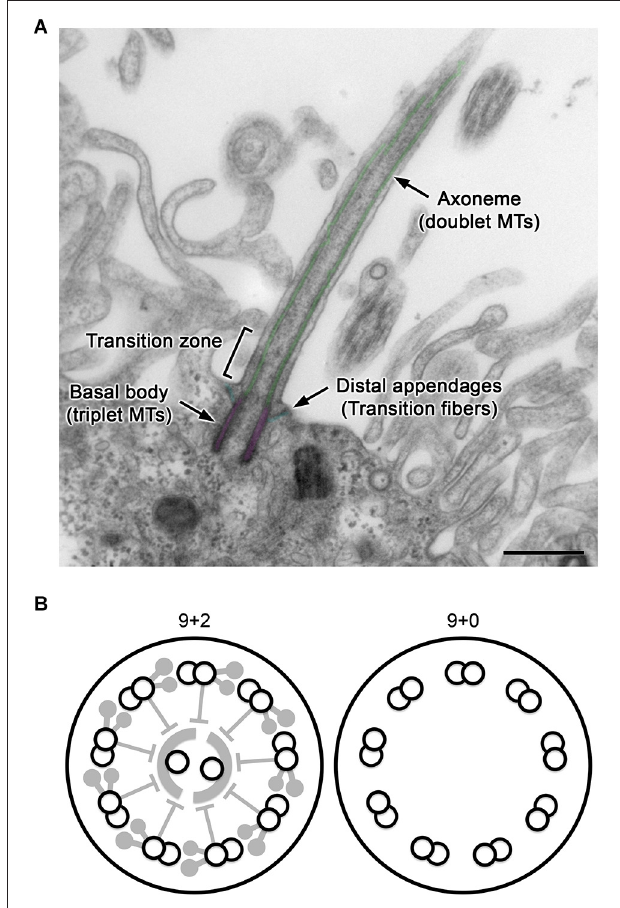
FIGURE 1 | General structure of cilia. (A) A longitudinal section of a CPEC cilium. The cilium emerges from the microvilli-rich apical cell surface. The structure is supported by the axoneme and basal body (pseudo-colored in green and magenta, respectively). The distal appendage (cyan) connects to the basal body and cell membrane. In the transition zone, characteristic Y-shaped structures bridges the axoneme and ciliary membrane, which can be recognized in horizontal sections. MTs, microtubules. Bar, 500 nm. (B) Schematics of transverse sections of motile 9+2 and non-motile 9+0